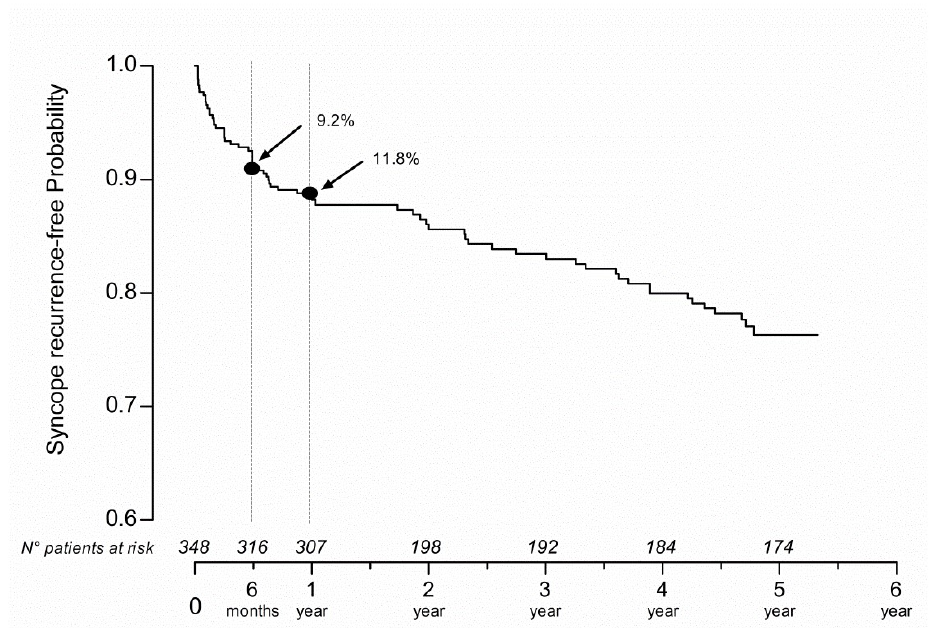
Figure 2. Risk of syncope recurrence within 5-year follow-up. Risk of syncope recurrence within 5-year follow-up as shown by the Kaplan-Meyer curve. On the X axis, the time of follow-up and the corresponding number of subjects at risk for syncope recurrence are reported. Notice that 9.2% and 11.8% of patients suffered from a syncope relapse within six-month and 1-year follow-up, respectively.